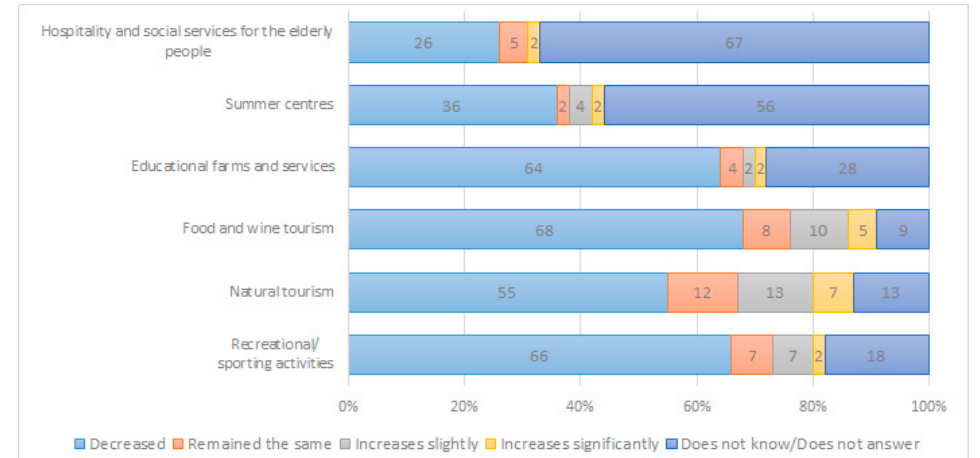
Figure 7. Perception of changes in the main tourism and hospitality activities (values in %) (author: our elaboration).